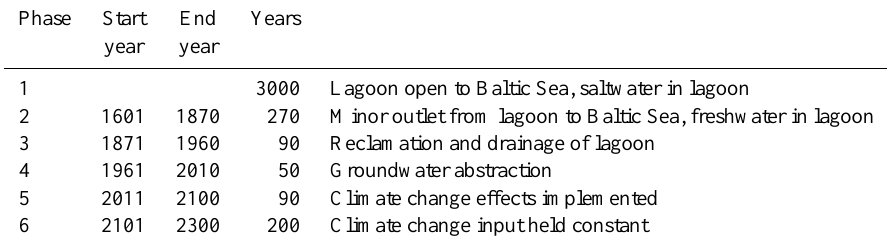
Table 1. Model phases (illustrated in Fig.